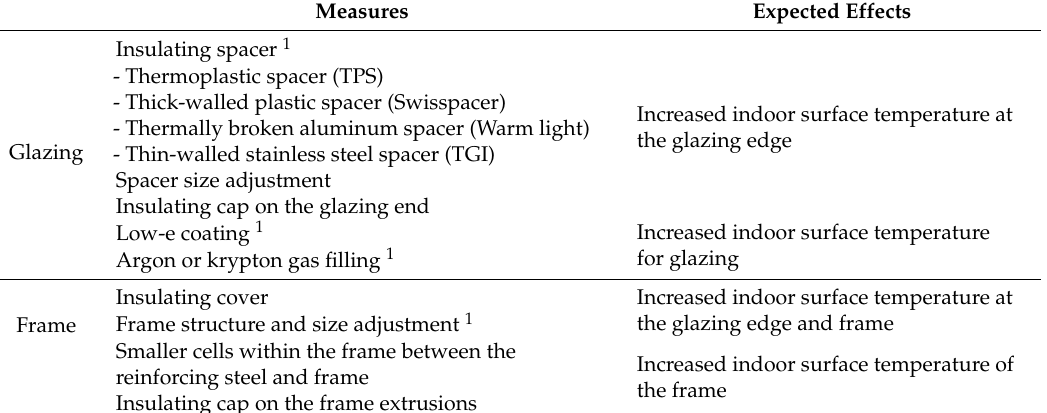
Table 1. Applicable measures for thermally improved window designs [23,24].